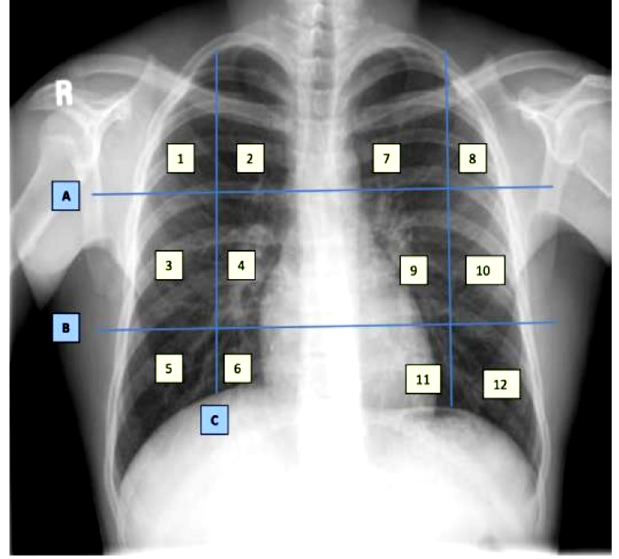
Figure 1. Chest X-ray zone segmentation and annotation [17].